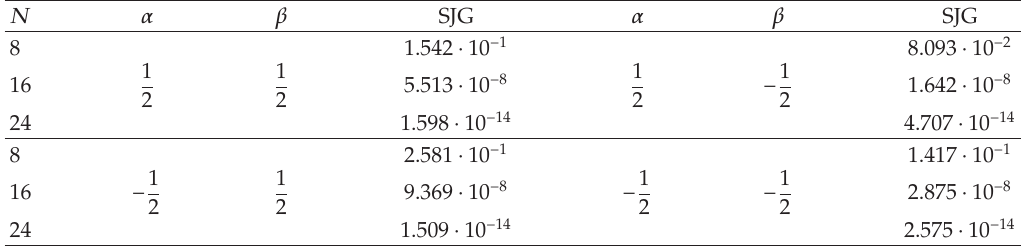
Table 1: Maximum pointwise error using SJG method for N (cid:9) 8 , 16 , 24 for Example 6.1. N